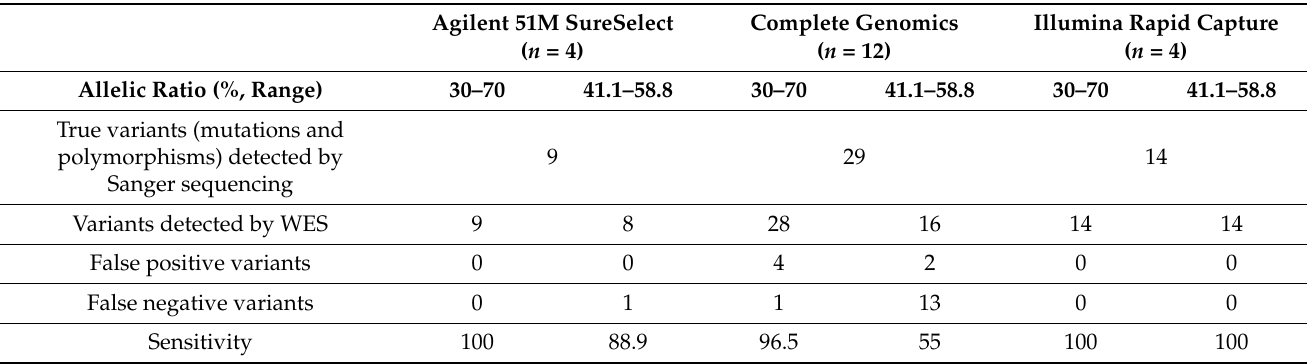
Table 2. Analytical performances of WES for genes associated with PPGL using different cut-off values of allelic ratio for heterozygote